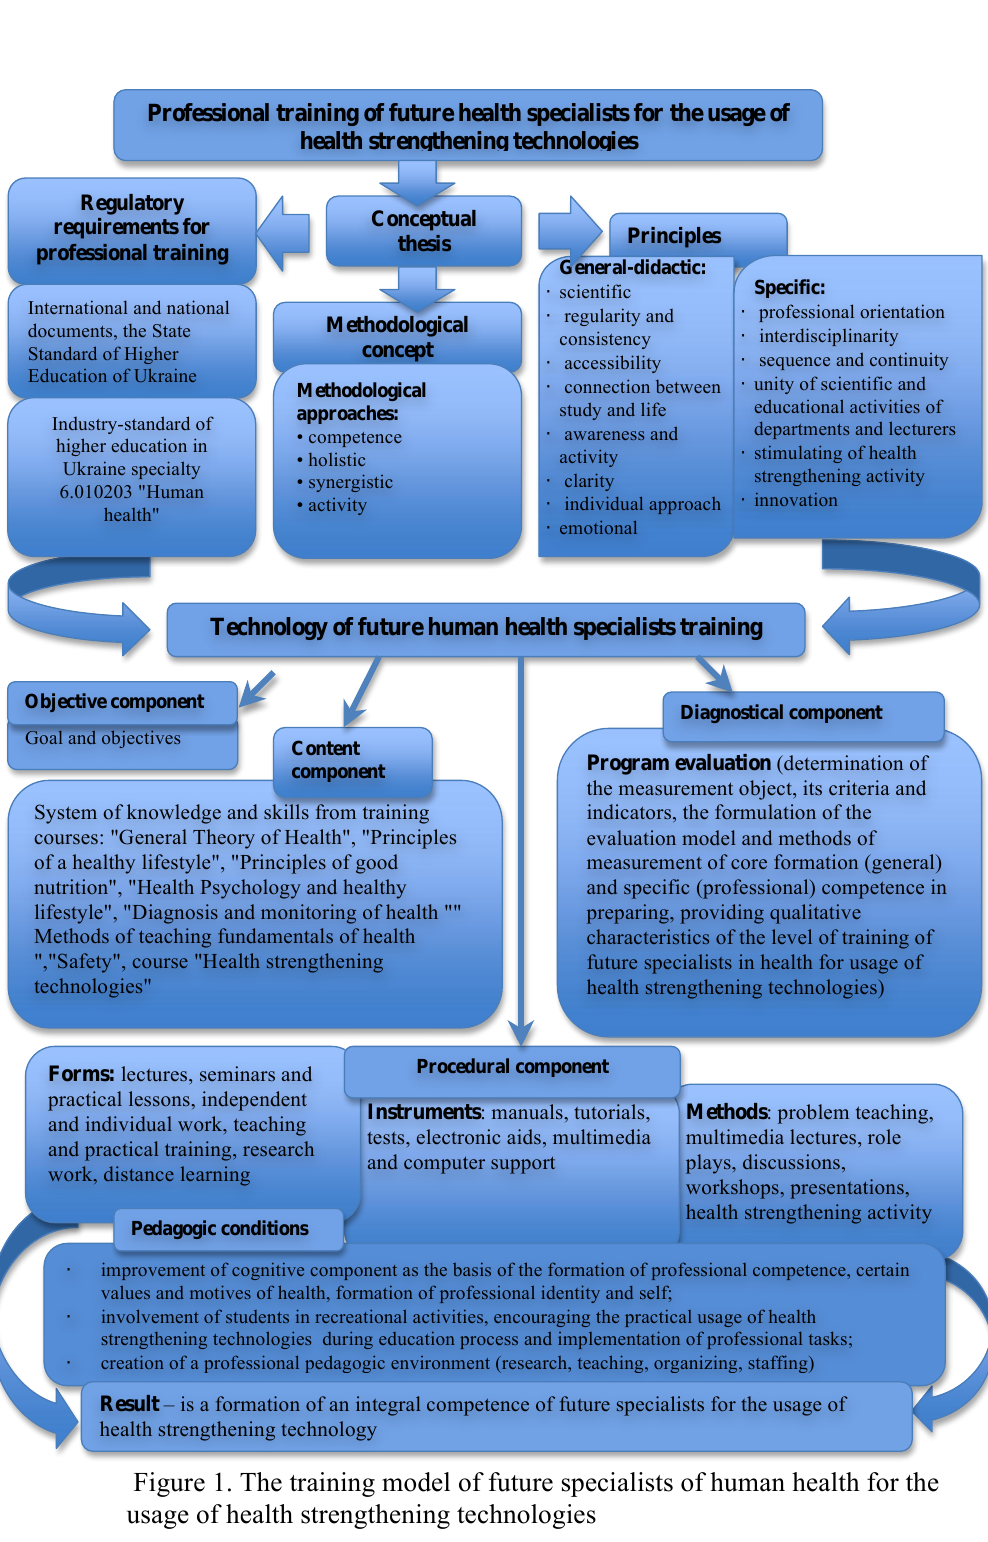
Figure 1. The training model of future specialists of human health for